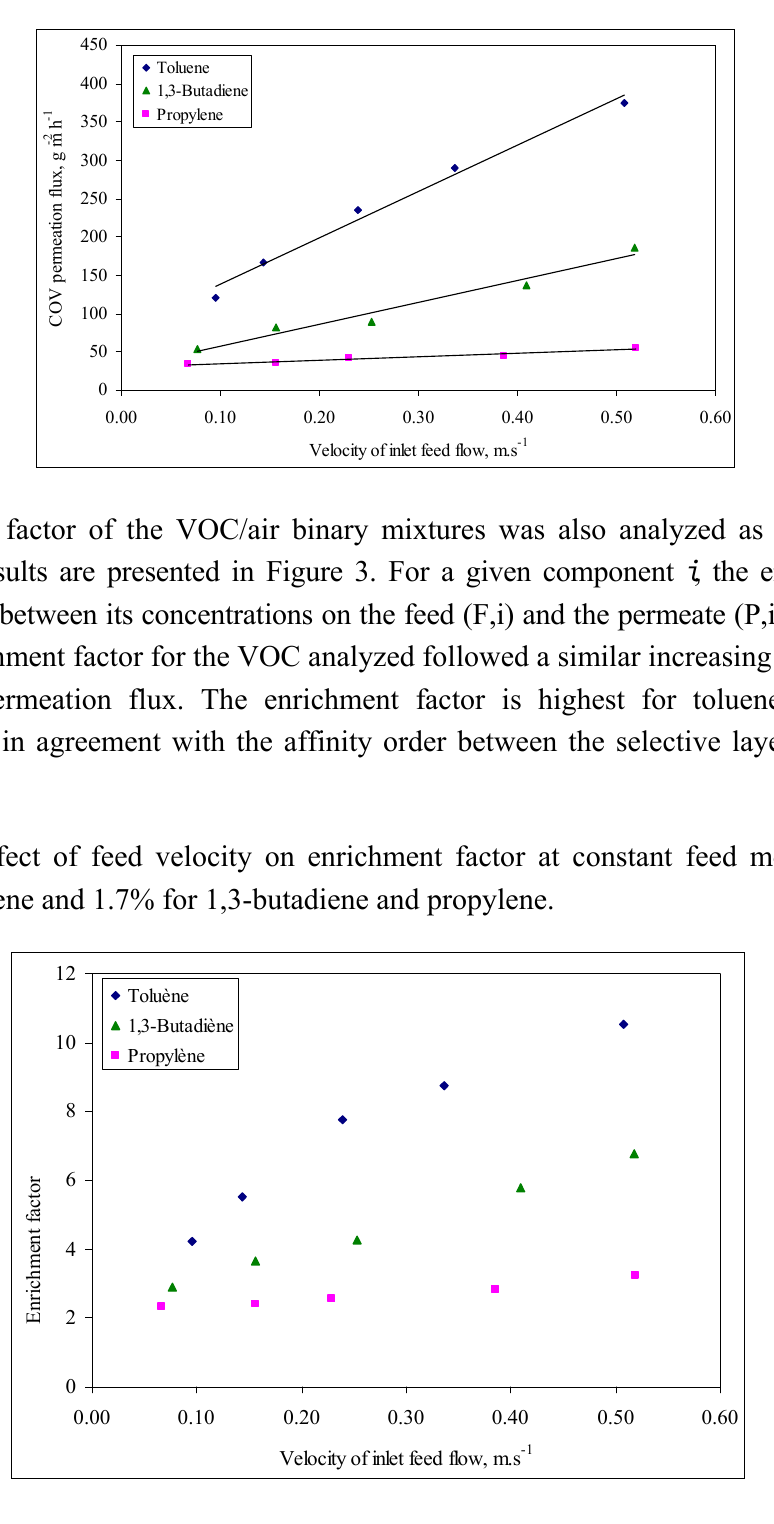
Figure 2. Effect of inlet feed flow rate on permeation flux at constant feed molar fraction: 1.5% for toluene and 1.7% for 1,3-butadiene and propylene.